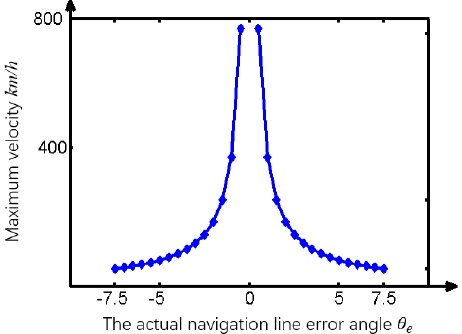
Figure 21. Maximum allowable velocity.